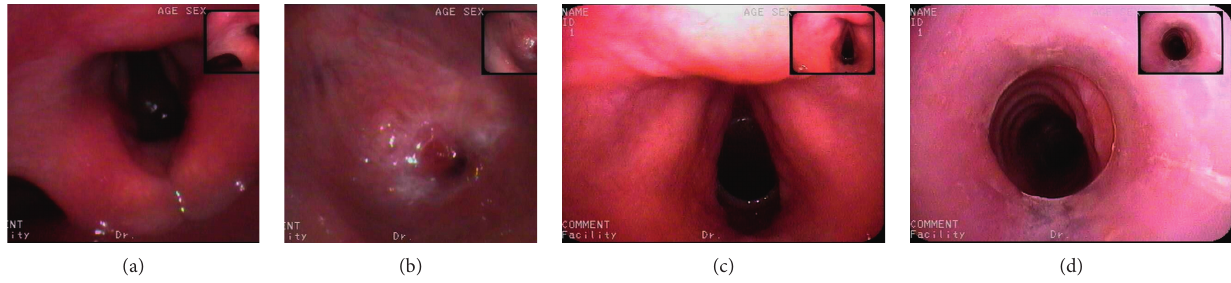
Figure 1: Airway and glottic status before and after surgery. (a) The preoperative hilum; (b) the preoperative airway; (c) the postoperative glottis; and (d) the postoperative airway. Table 1: Comparison of therapeutic effects between the two groups (%).